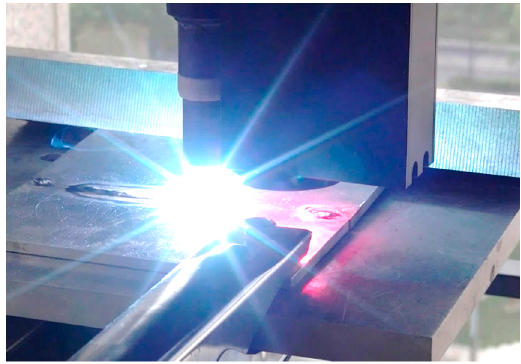
Figure 27. The welding scene in our experiments.